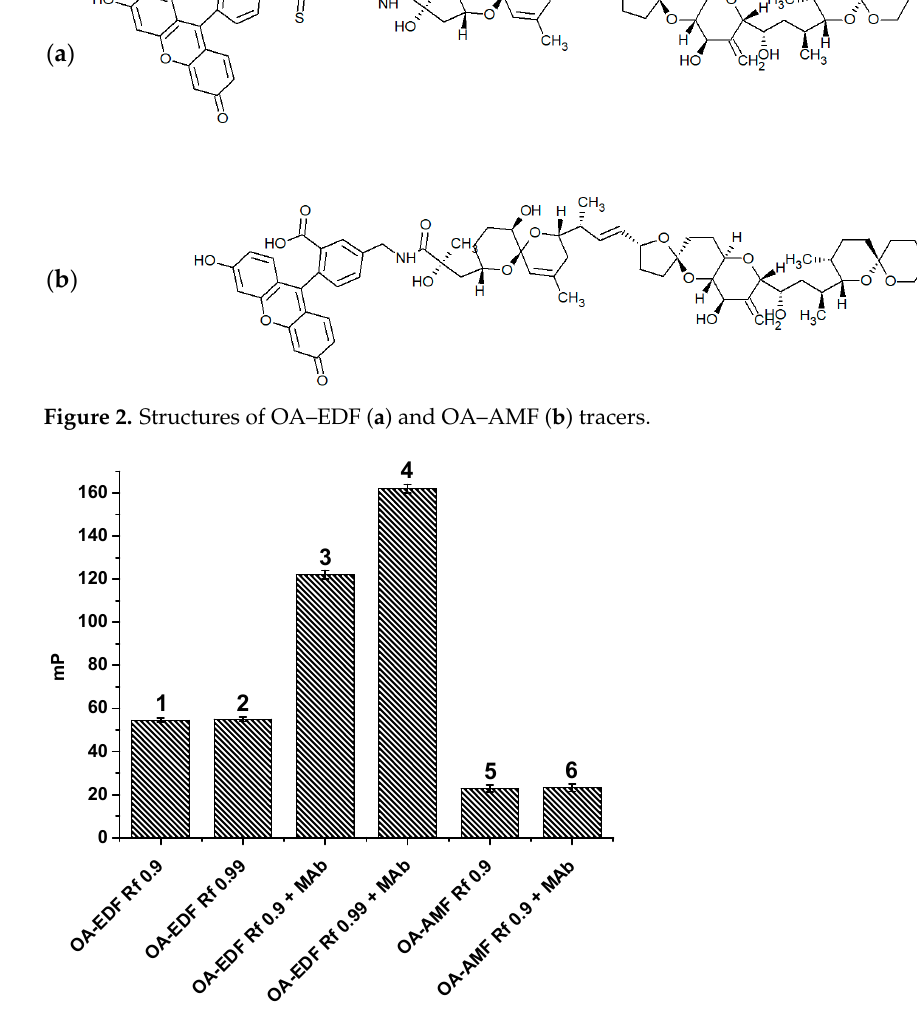
Figure 3. Registered mP values for solutions of free tracers and after their interaction with MAbs ( n =